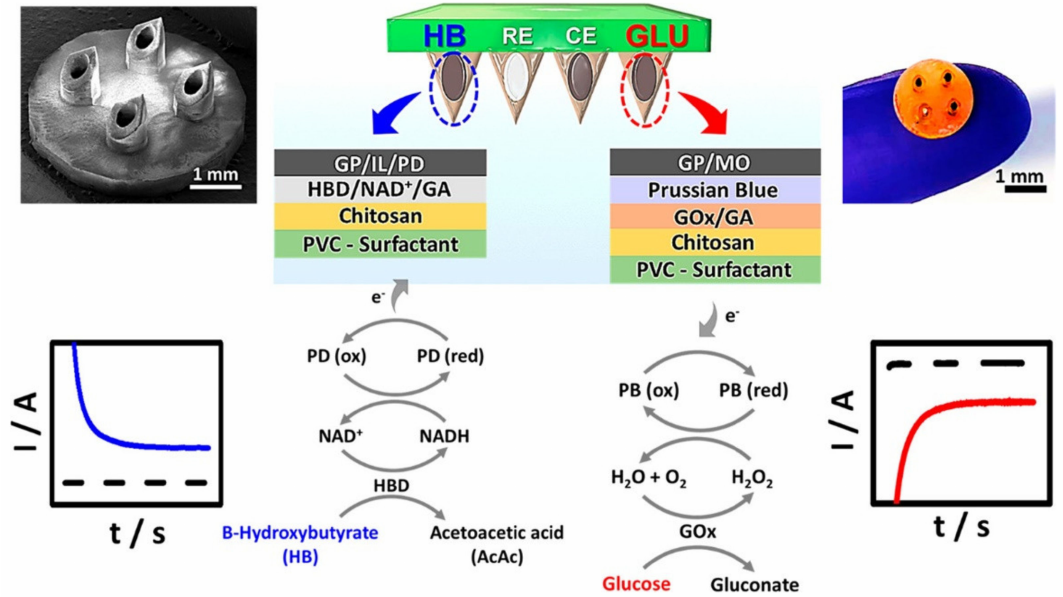
Figure 7. Top left: SEM image of the 2 × 2 arrays of hollow MNs. Top right: Optical image of the MN sensor. Middle: Schematic representation of the multilayer, modified dual-HB/GL sensor and the sensing mechanism. WE for HB (left) packed with GP/IL/PD and covered with the HBD/NAD+/GA-sensing layer. WE for GL (right) filled with